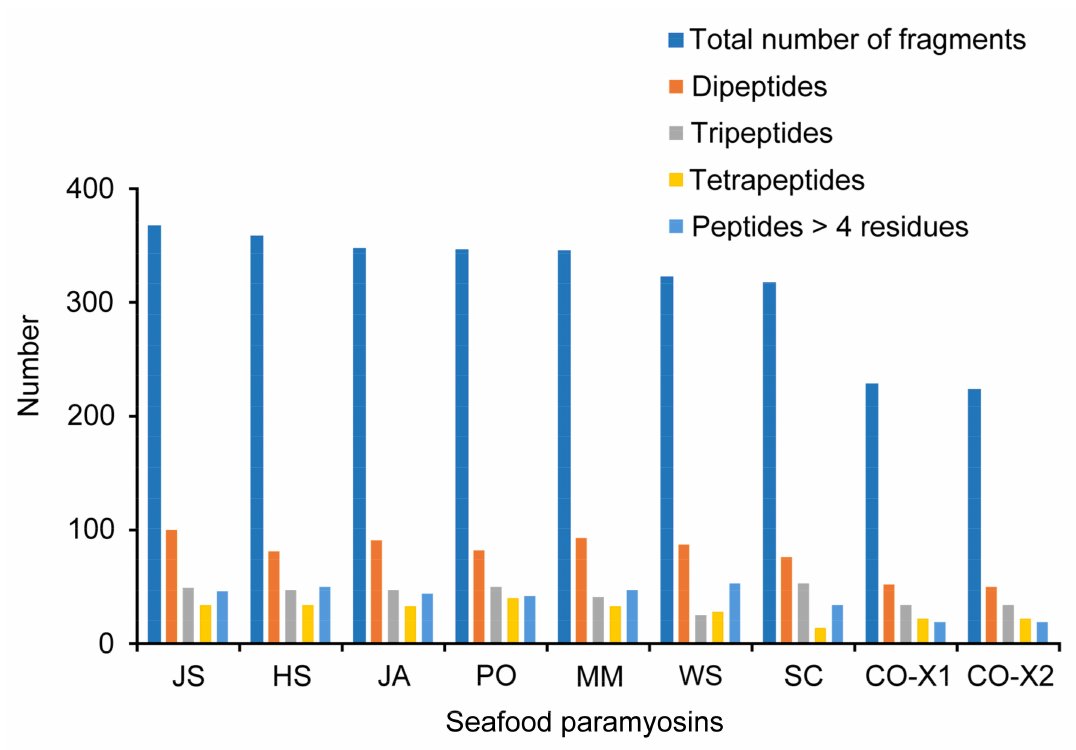
Figure 1. Distribution of peptides of different lengths released by in silico GI digestion of seafood paramyosins. An individual amino acid released from in silico GI digestion was counted as one